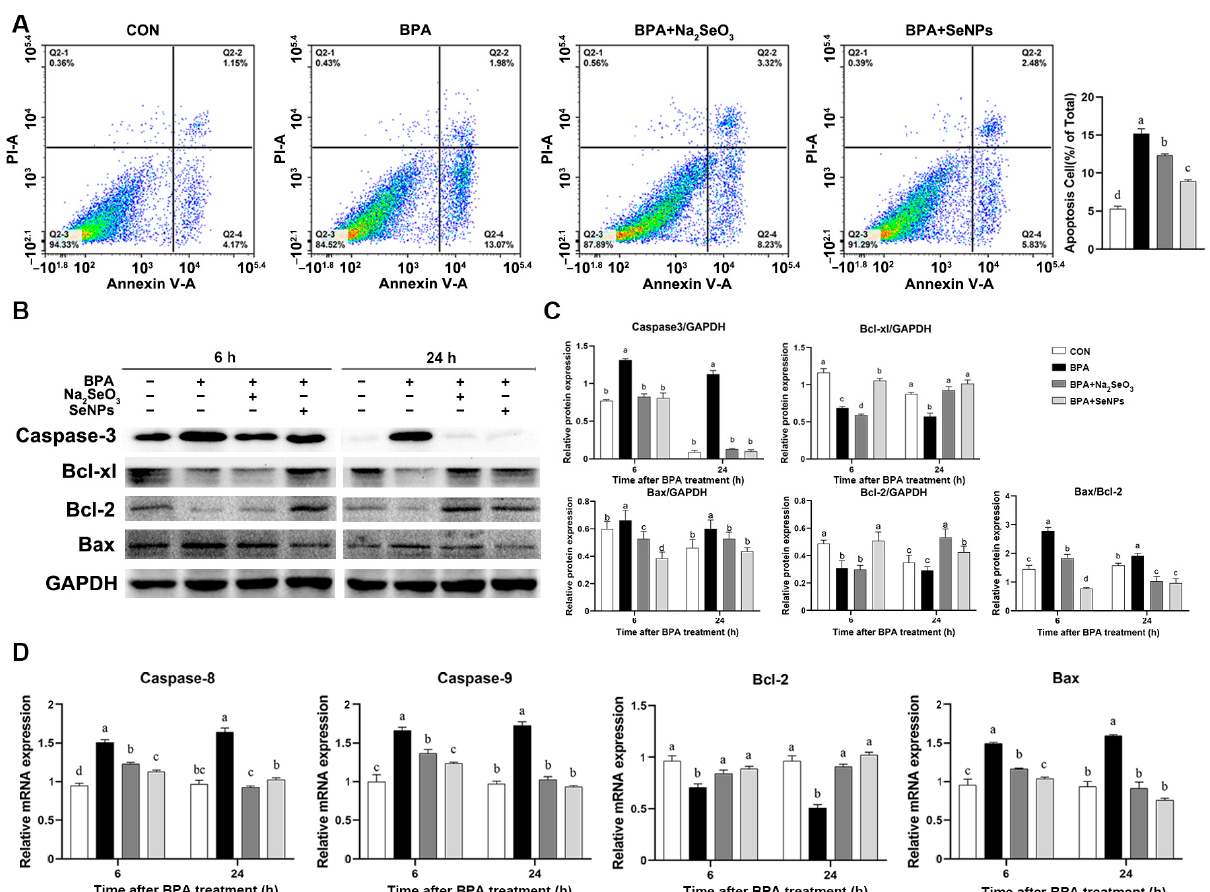
Figure 4. Effects of Na 2 SeO 3 and SeNPs treatment on apoptosis of IPEC-J2 cells induced by BPA. Cell apoptosis was determined by flow cytometric analysis and analyzed ( A ). Representative panels showing expression of caspase 3, Bcl-xl, Bax, and Bcl-2 proteins by Western blotting at 6 and 24 h after BPA challenge ( B ). Expression of GAPDH was measured as an internal control. Results are presented as the ratio of caspase 3, Bcl-xl, Bax, and Bcl-2 protein band intensities to that of GAPDH, and the cellular protein Bcl-2 was used as an internal control for Bax ( C ). The relative expression of mRNAs for the caspase-8 , caspase-9 , Bcl-2 , and Bax genes was analyzed by quantitative real-time PCR ( D ). Data are presented as the means ± SEM of three independent experiments. a,b,c,d Mean values within a row with different superscript letters were significantly different ( p <